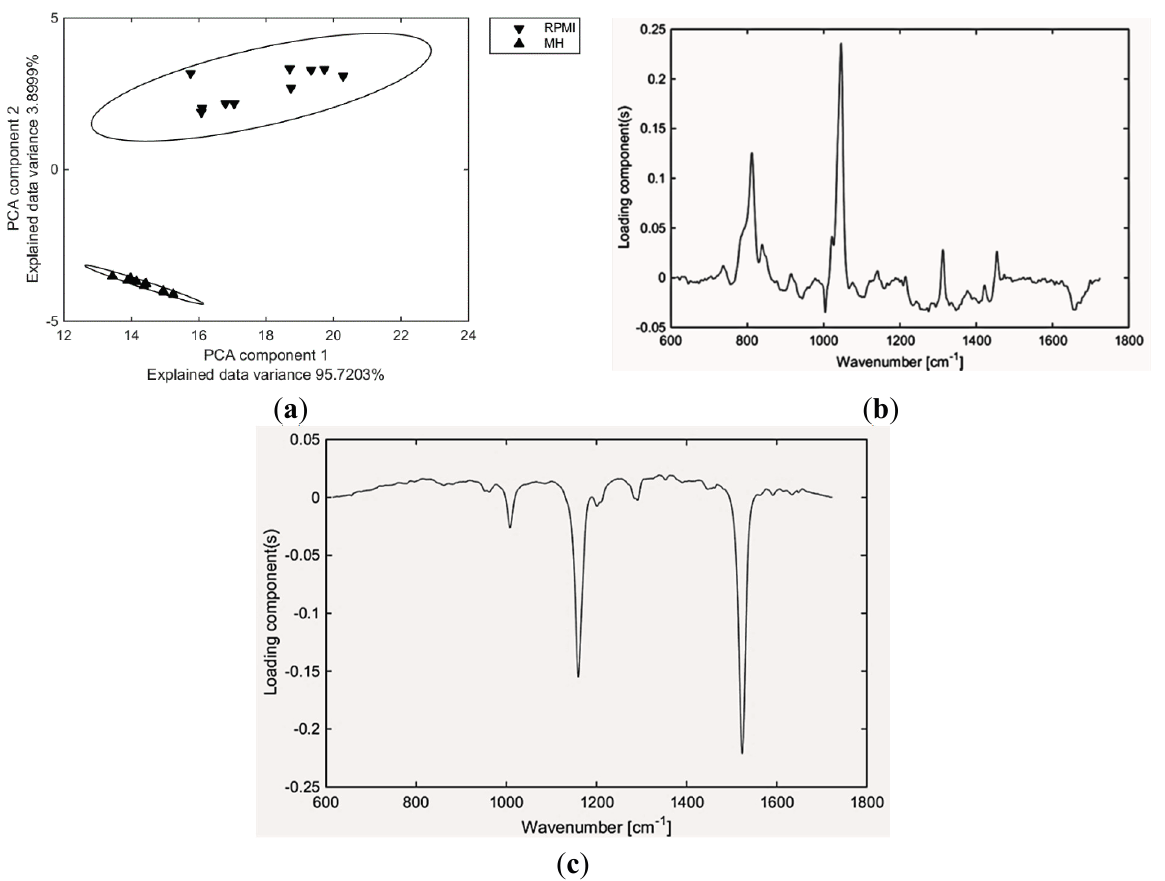
Figure 3. ( a ) Scores plot of the first two principal components relation for E. coli cultured on two different media—top cluster RPMI (down-triangle), bottom cluster MH